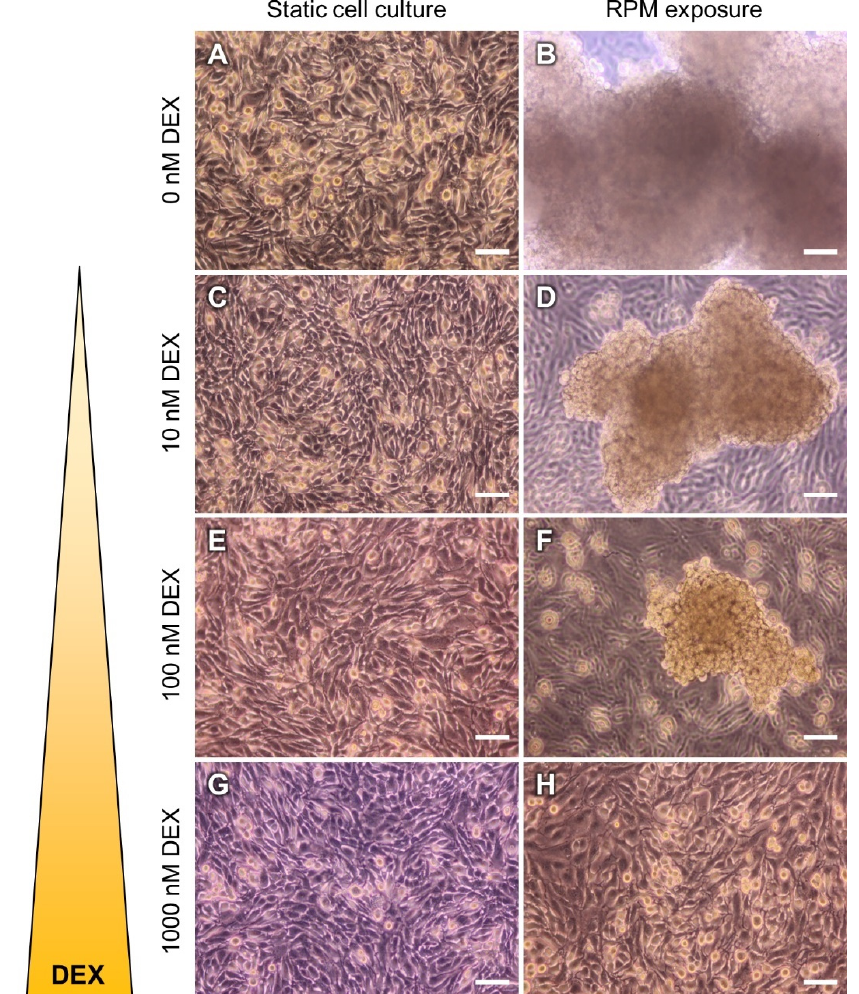
Figure 2. Impact of DEX on the spheroid formation ability of follicular thyroid cancer (FTC)-133 cells exposed to a random positioning machine (RPM). ( A, B ) After three days cells showed a dose-dependent inhibition of spheroid formation when treated with ( C, D ) 10 nM DEX, ( E, F ) 100 nM DEX, or ( G, H ) 1000 nM DEX on the RPM (right column). Scale bars: 100 µm.